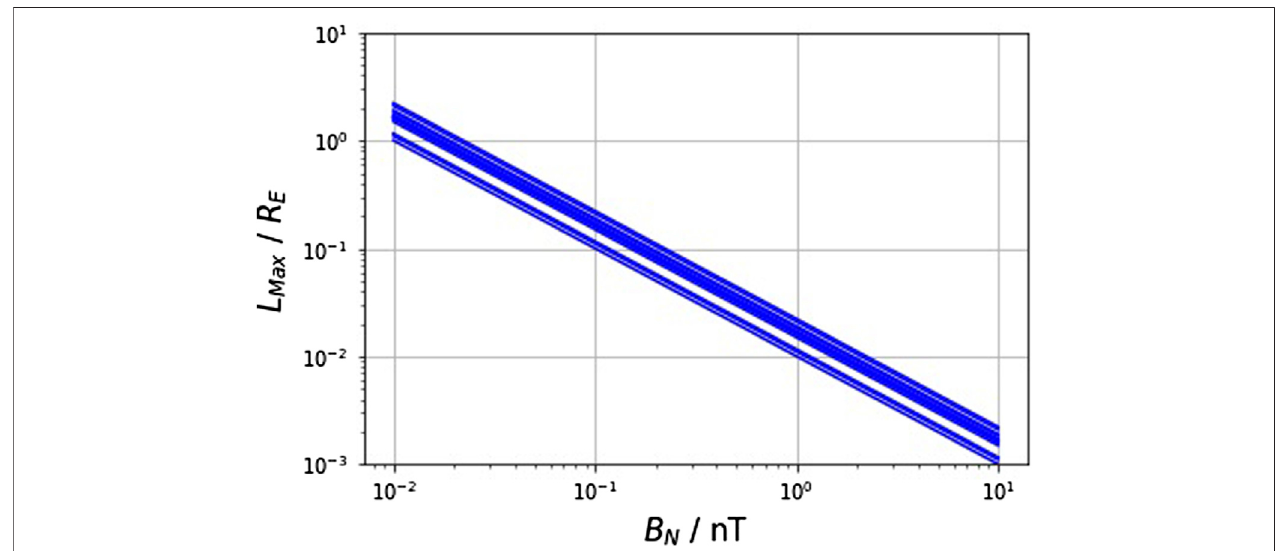
FIGURE 2 | Evaluation of the criterion for marginal stability. The blue lines represent marginal stability for each of the 15 events identi fi ed by our neural network method, evaluated through Eq. 4 . For conditions below these lines we infer the plasma is tearing unstable (Liu et al., 2014).